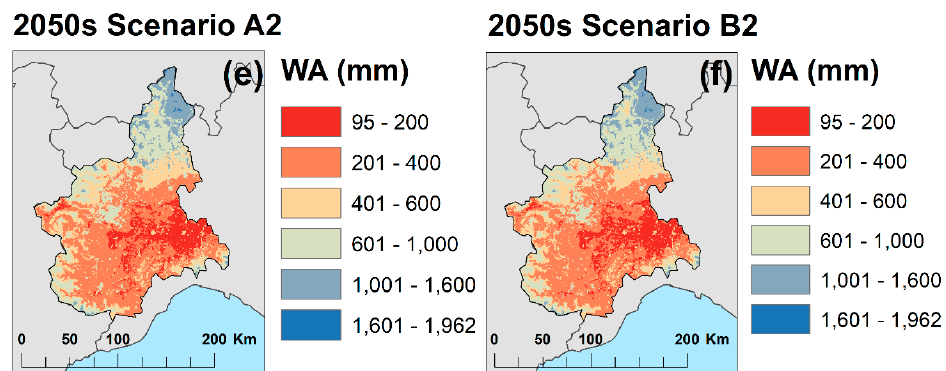
Figure 5. Spatial distribution of water availability (WA) in the Piedmont region. ( a ) WA related to the